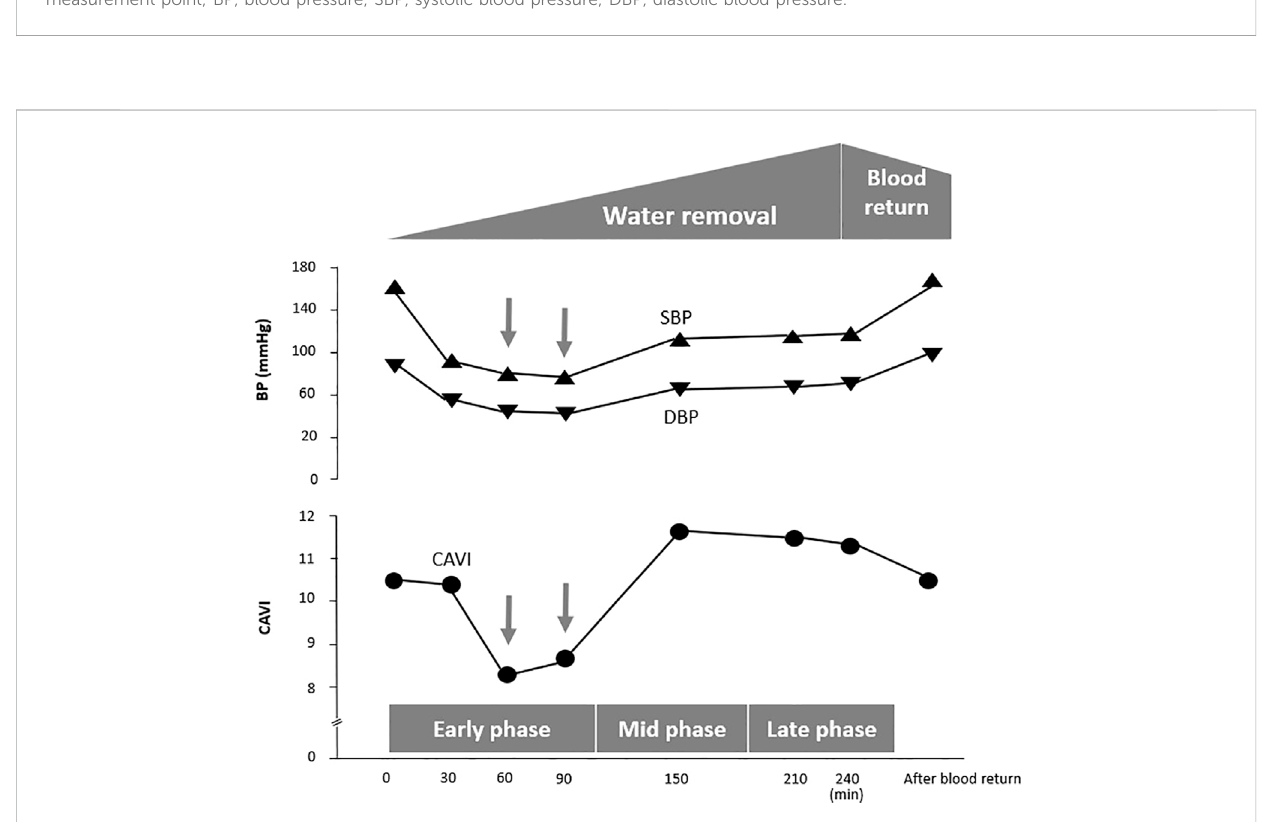
A case in which CAVI decreases with a reduction in BP at the early phase of hemodialysis. Case. An 85-year-old man with diabetic nephropathy. CAVI, cardio – ankle vascular index; SBP, systolic blood pressure; DBP, diastolic blood